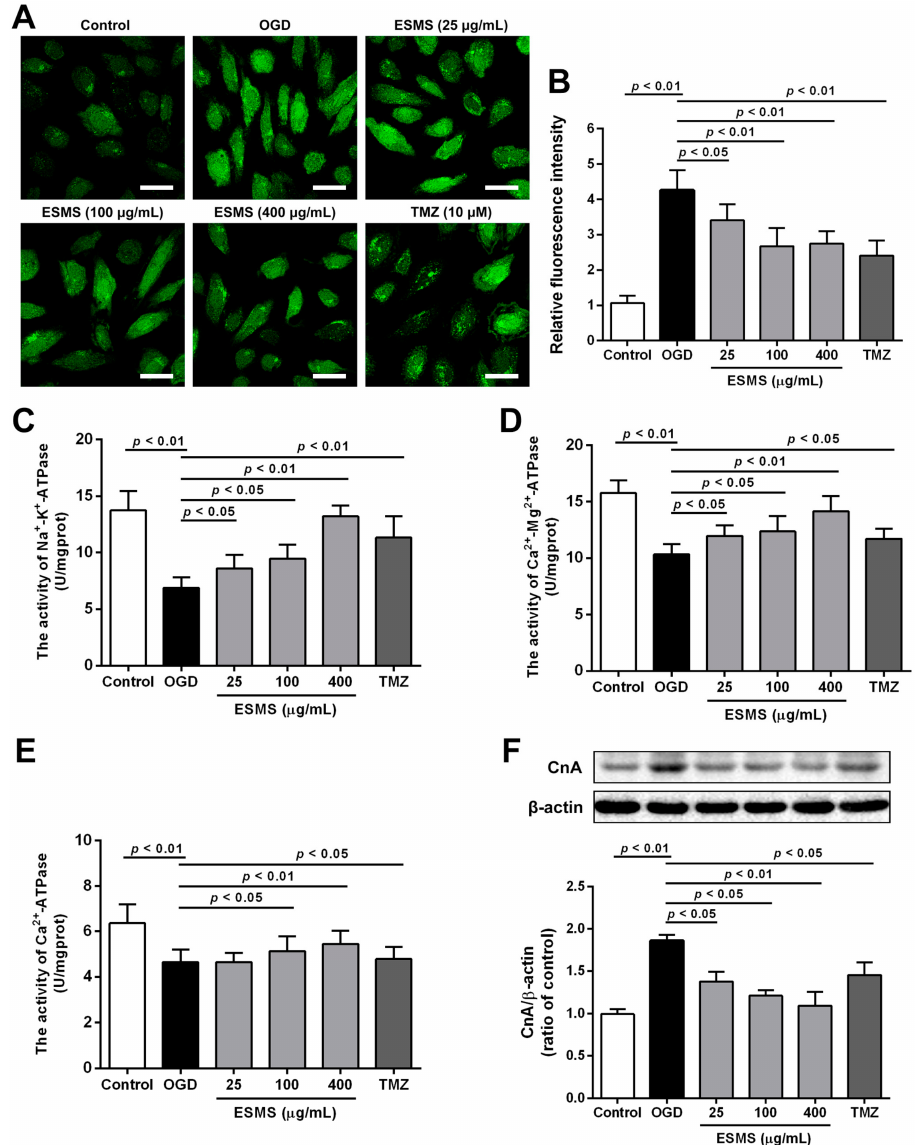
Figure 5. ESMS reduced intracellular Ca 2+ levels, increased ATPase activity and reduced CnA protein expression in H9c2 cells subjected to OGD: ( A ) the intracellular Ca 2+ levels were evaluated by probe Fluo-3 AM. Bar is 40 µ m ( n = 3); ( B ) quantitative analysis of intracellular Ca 2+ levels ( n = 3); Na + -K + -ATPase ( C ), Ca 2+ -Mg 2+ -ATPase ( D ), and Ca 2+ -ATPase ( E ) activities were determined ( n = 6); and ( F ) CnA protein expression was detected by Western blotting ( n = 3). Results were presented as mean ± SD. TMZ = Trimetazidine dihydrochloride (positive control). 2.7. ESMS Restored Mitochondrial Membrane Potential and Cellular ATP in H9c2 Cells Subjected to